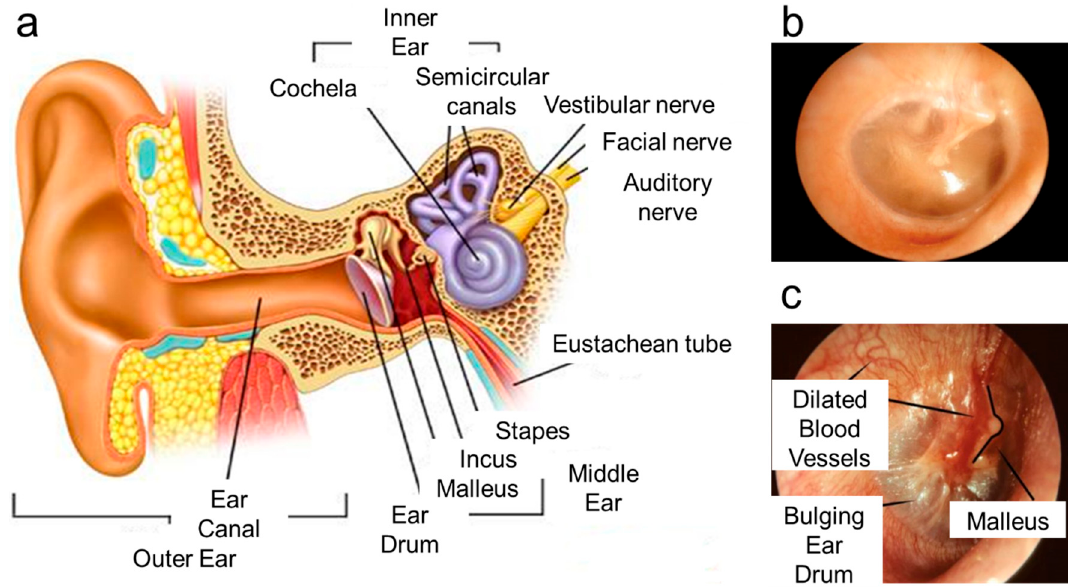
Figure 1. ( a ) Anatomy of a human ear. Adopted and modified from [9]. ( b ) Healthy human ear. (c ) Infected human ear. Adopted and modified from [23], Copyright Microbiology Society, 2015.